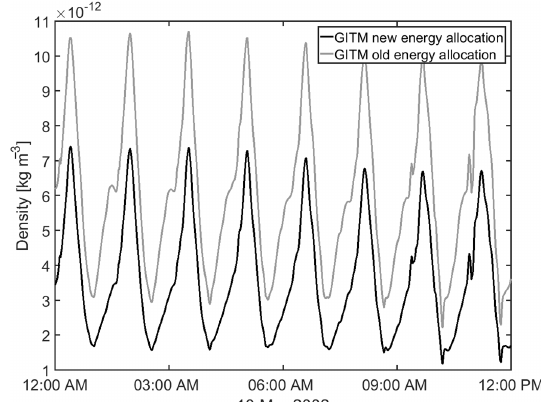
Figure 24. Effect of the new and old allocation of the exothermic excess energy on the simulated density. The density is simulated along the CHAMP trajectory as an